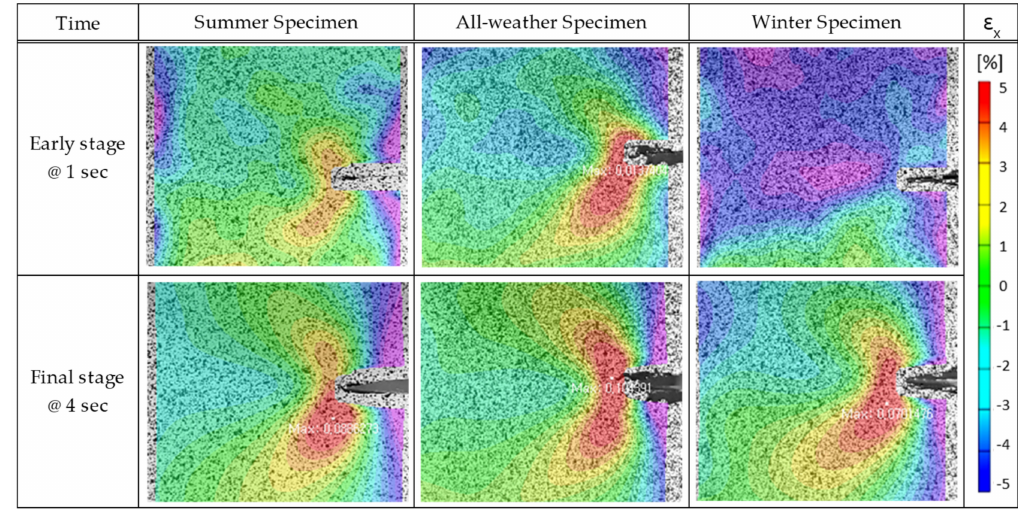
Figure 12. Major strain contours at 50